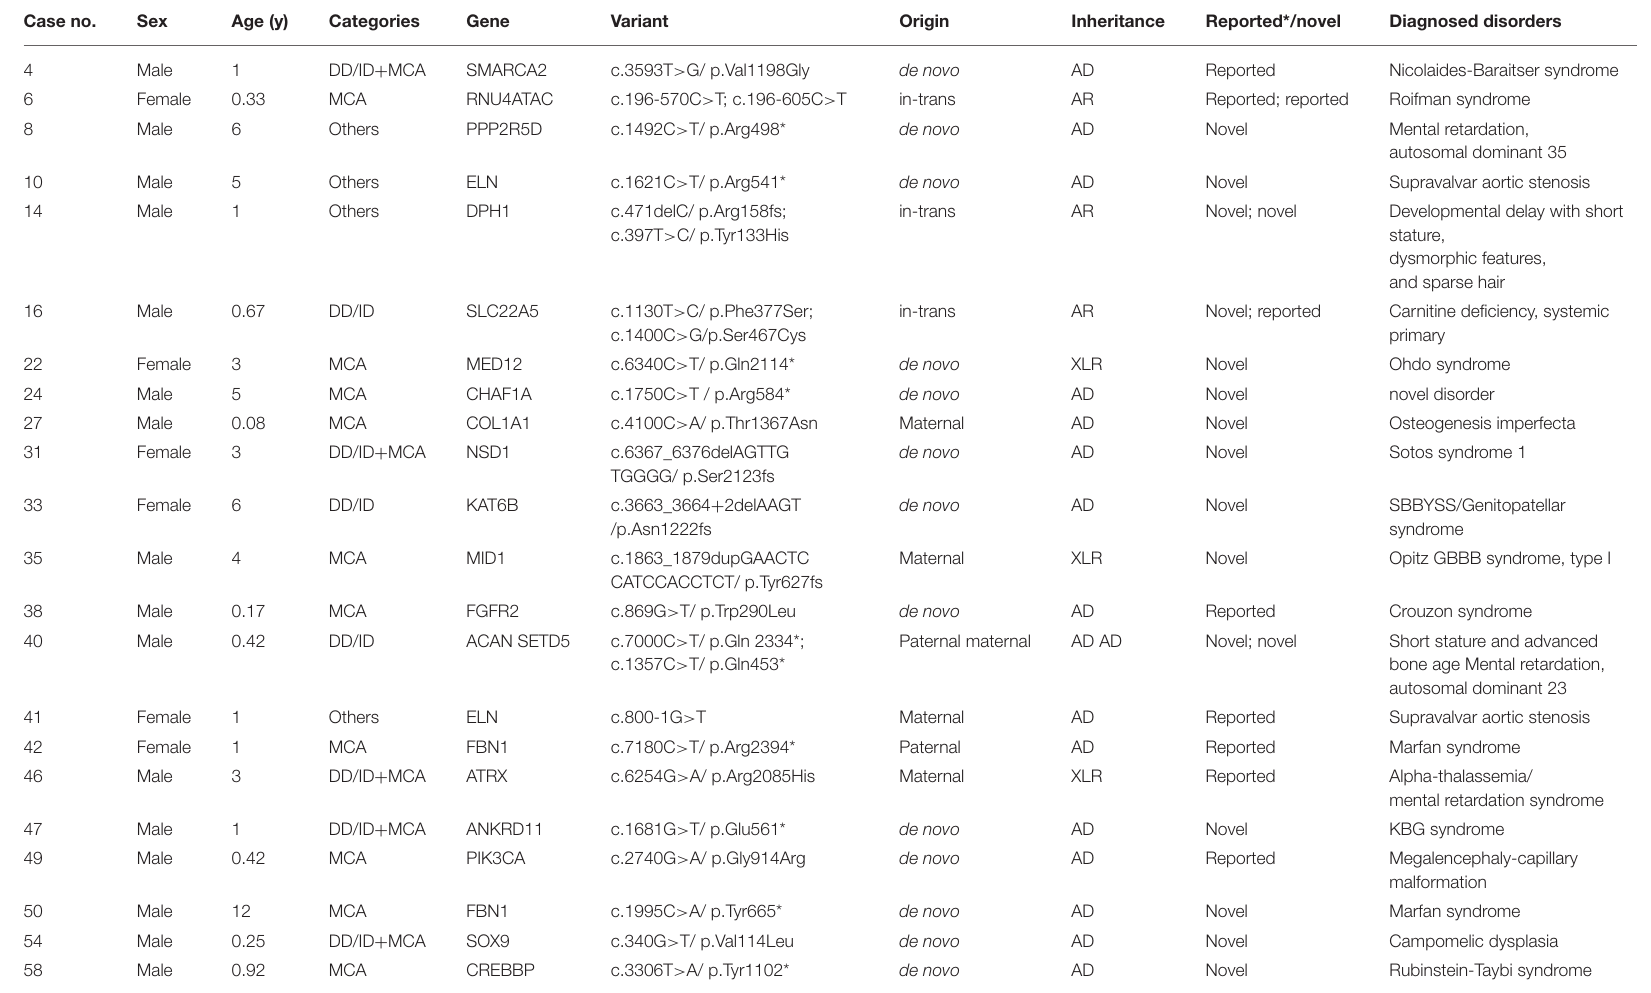
TABLE 2 | Patients with pathogenic and likely pathogenic variants identified by whole exome sequencing. Case